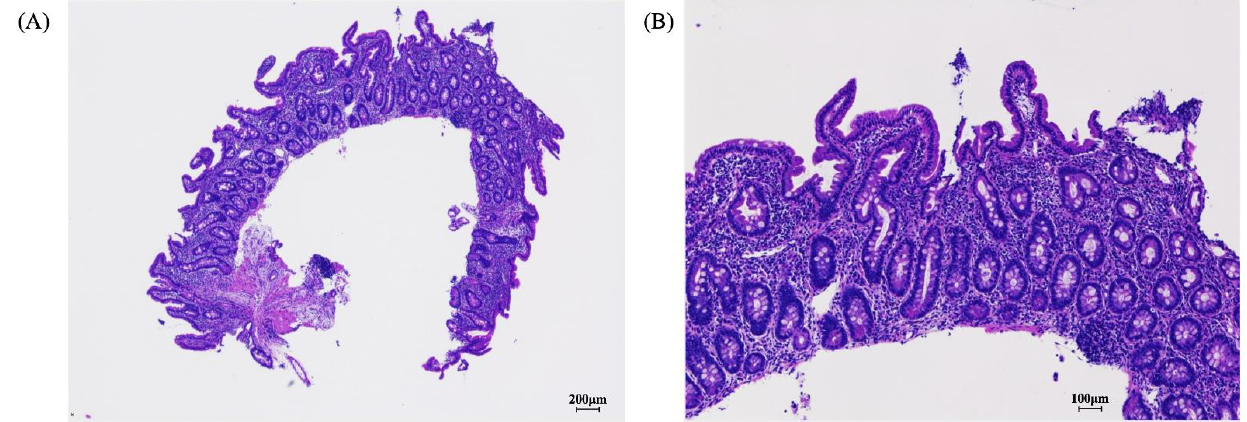
Figure 2. After 5 months of elimination diet therapy, pathologic findings in the gastrointestinal mu- cosa showed restored normal mucosal villous structure with well-differentiated ductal arrangement ( A , B